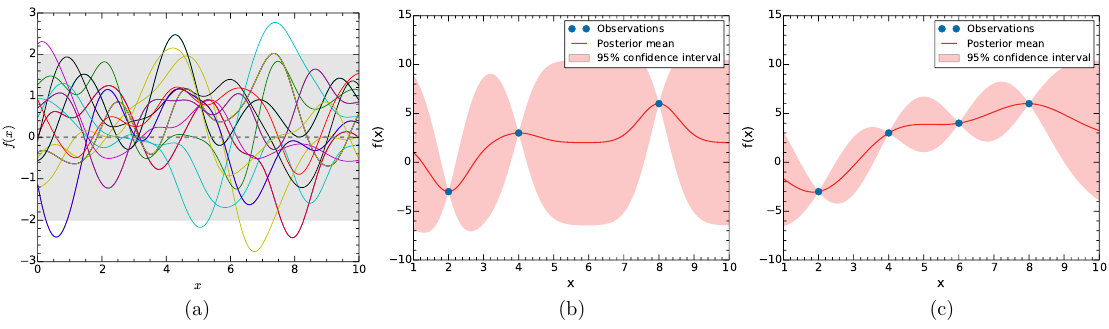
Figure 1. Gaussian process (GP) prior and posterior distributions: ( a ) Twenty randomly selected samples from the prior distribution, with zero mean and σ = 1, using a squared exponential covariance kernel; ( b ) Regression results after training the GP with three error-free data points; ( c ) Same as in panel (b), but note the improved result with the addition of one more data